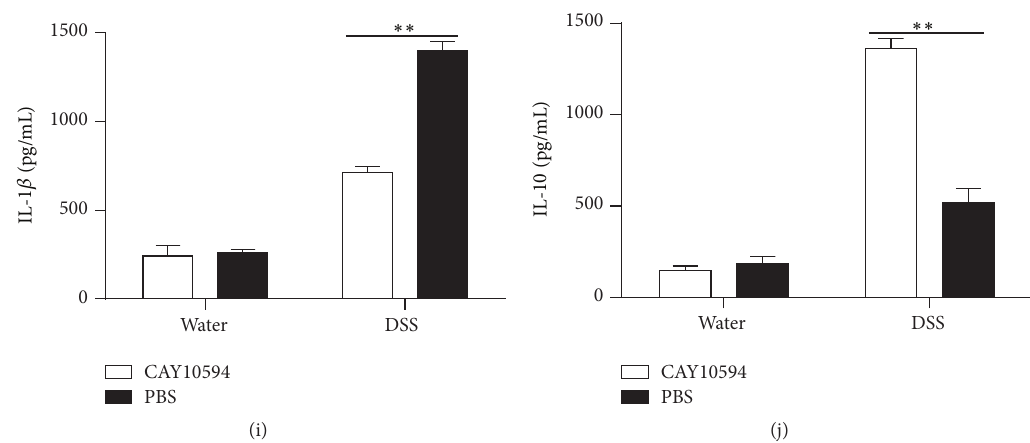
Figure 6: Cytokines profiles in colonic tissues from DSS-induced colitis mice after PLD2 inhibition. ((a)–(f)) Colonic tissues were obtained frommiceonday10afterDSS-inducedcolitis,andtotalRNAwasextractedtodetectmRNAlevelsofvariouscytokinesbyqRT-PCR. ∗ 𝑝 < 0.05 and ∗∗ 𝑝 < 0.01 versus controls. ((g)–(j)) Colonic tissues (0.01 g/sample) from mice on day 10 after DSS-induced colitis were cultured ex vivo at 37 ∘ C for 24 h; the supernatants were then collected for detection of TNF- 𝛼 , IL-17A, IL-1 𝛽 , and IL-10 by ELISA. ∗ 𝑝 < 0.05 and ∗∗ 𝑝 < 0.01 versus